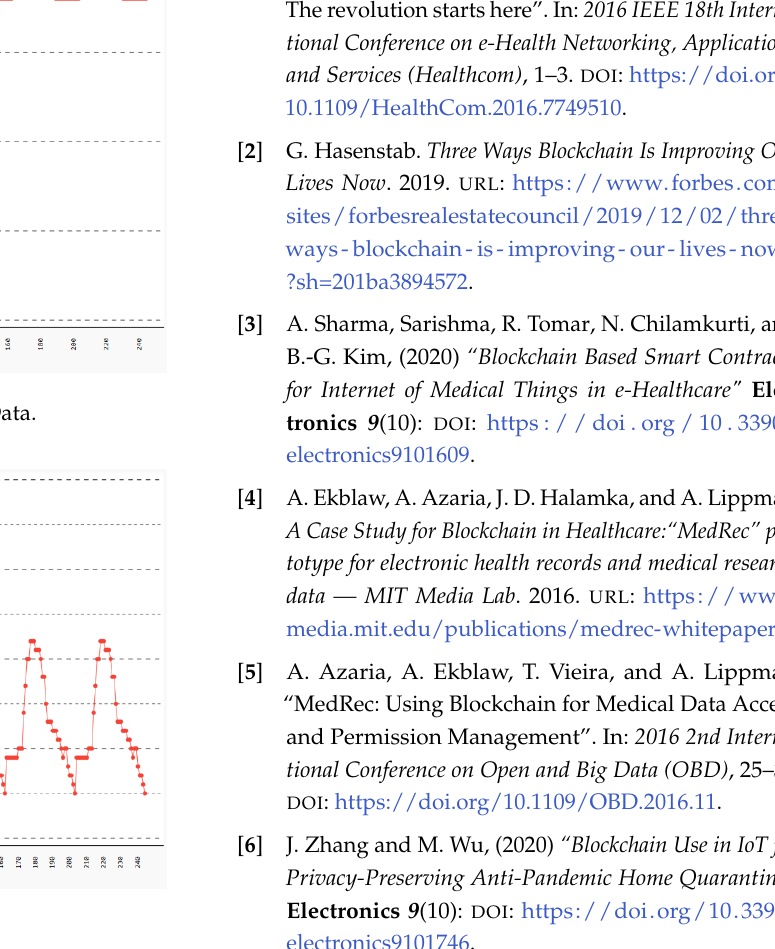
Fig. 8. Heart Rate